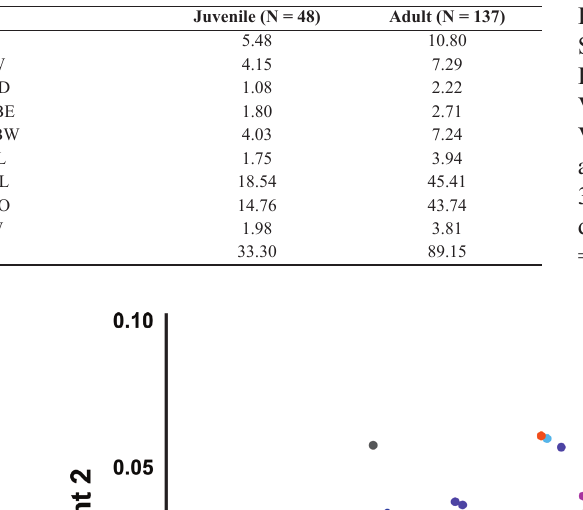
Table 1. Mean linear measurements (in mm) of juvenile and adult P. robertsi . Measurements are: Head length (HL), from the tip of the snout to the neck; head width (HW), across the widest point of the head; left eye diameter (LED); width between eyes (WBE); median body width (MBW), across the trunk midway between the front and hind limb insertions; posterior femur length (PFL); snout vent length (SVL); tail length (TLO); tail width (TW); total length (TL), from the posterior left limb in- sertion to the tip of the longest outstretched toe.